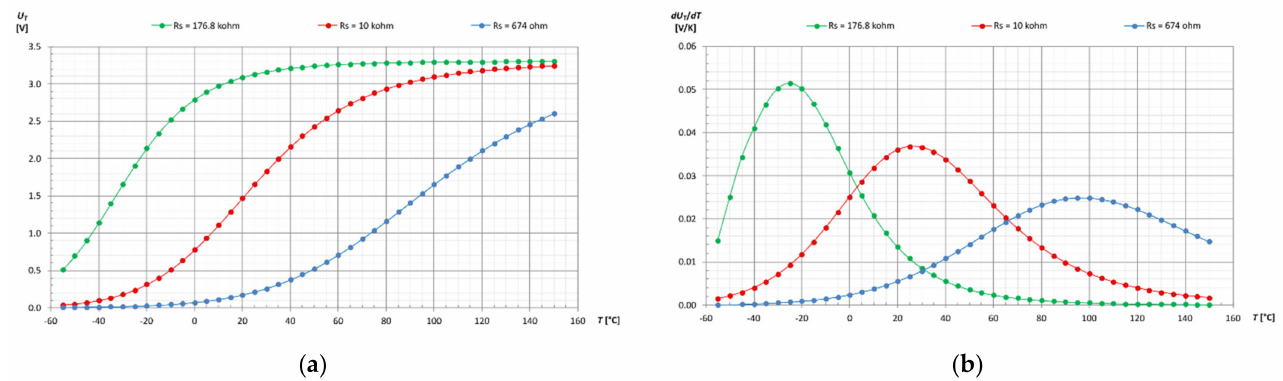
Figure 4. Influence of resistance R S value: ( a ) Voltage vs. temperature; ( b ) Voltage measurement sensitivity vs.